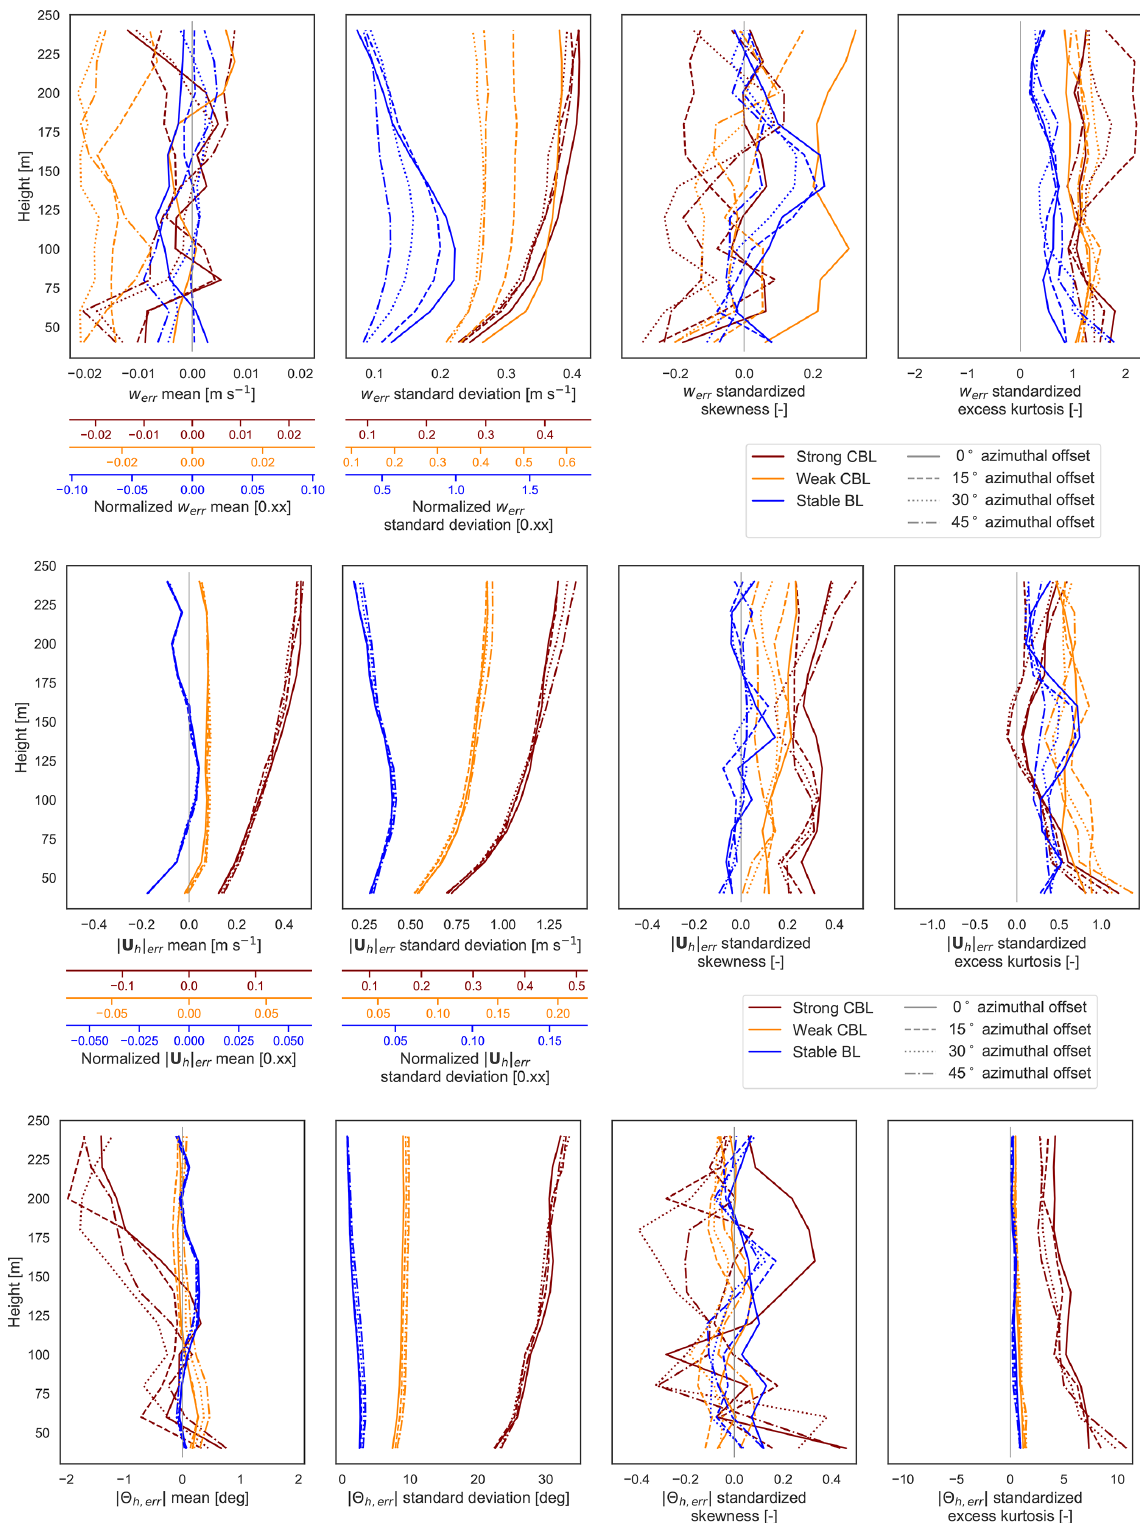
Figure A2. Comparison of error distribution moments over disaggregated lidar orientation angles. No offset, same axes as LES domain (solid), rotated 15 ◦ counterclockwise from LES domain axes (dashed), rotated 30 ◦ counterclockwise (dotted), and rotated 45 ◦ counterclock- wise